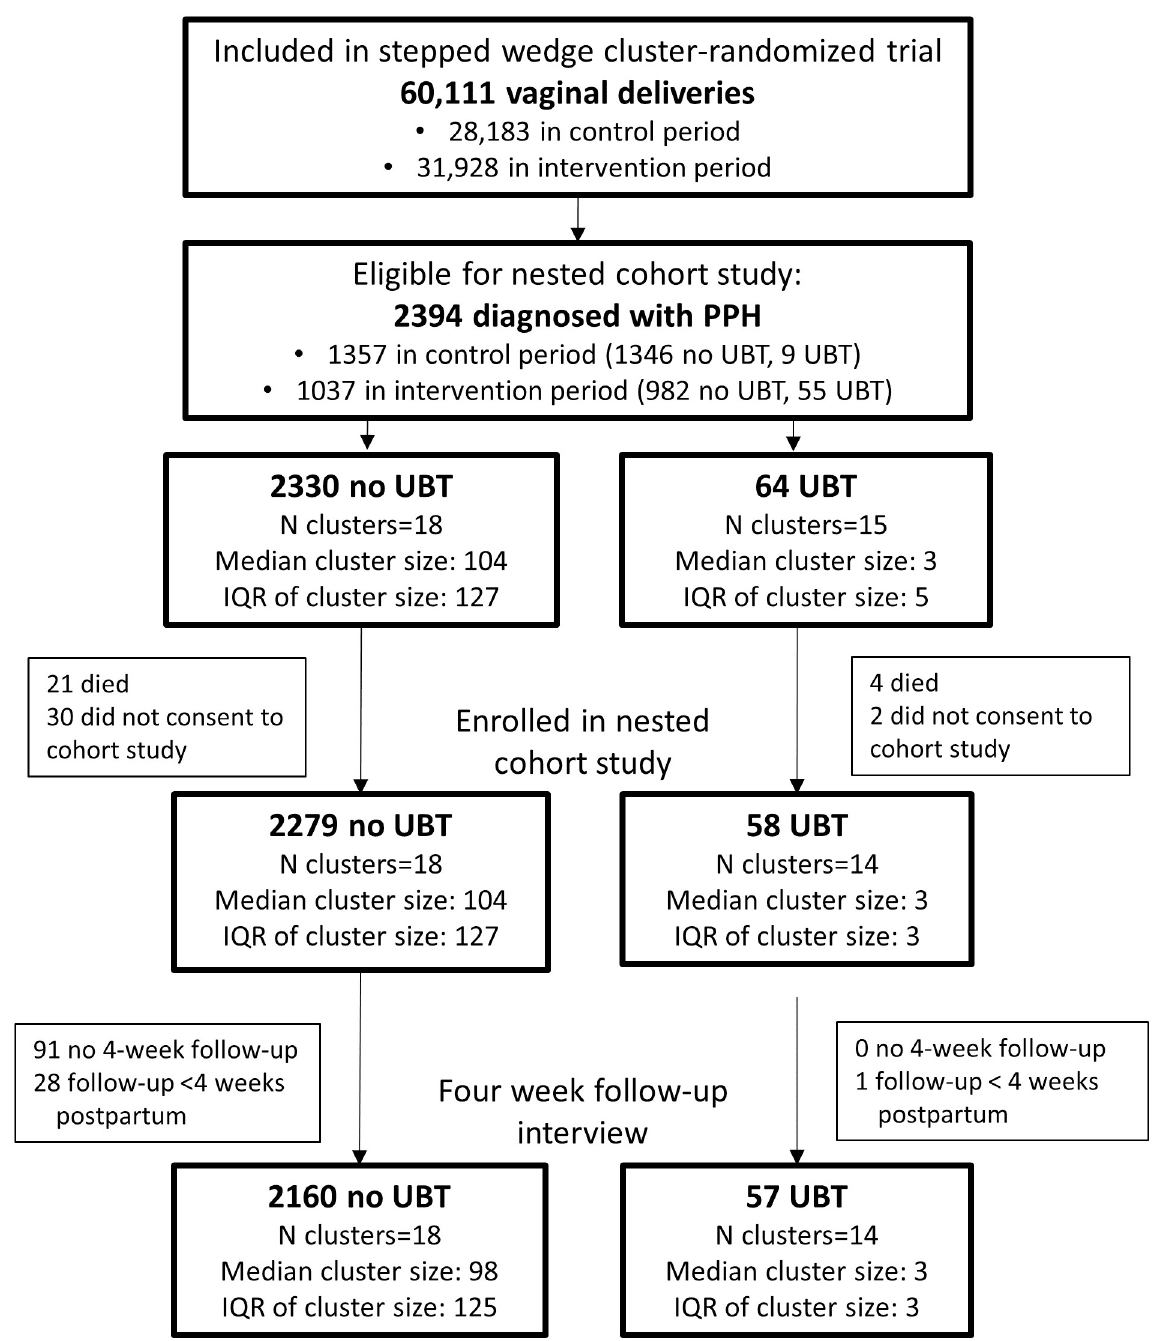
Fig 1. Enrollment and follow-up of cohort study nested in a stepped wedge, cluster-randomized trial of UBT introduction (i.e. effectiveness trial). Abbreviations: PPH = postpartum hemorrhage, UBT = uterine balloon